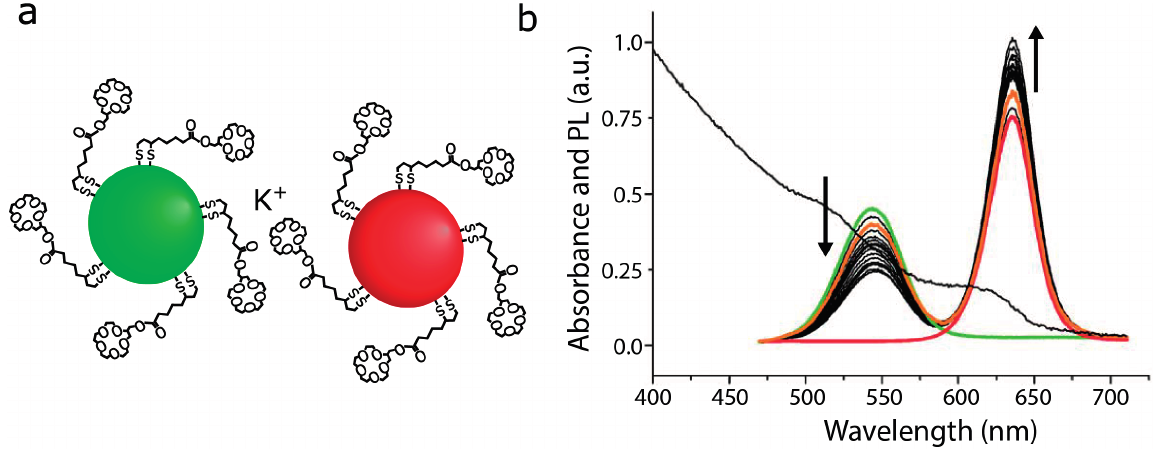
Figure 11. ( a ) Schematic of donor and acceptor QDs coated with 15-crown-5, which selectively interacts with potassium ions. Schematic is not drawn to scale; ( b ) PL spectra of the isolated donor and acceptor QDs (green and red lines, respectively). PL spectra of mixed QD populations after adding 2 n × 3.6 μ M of KClO 4 (black lines). Reversibility demonstrated by adding 1 M Na + after the n -th addition of K + (orange line). Absorption of spectrum of the QD mixture shown overlaid behind the PL spectra (black line); (b) reprinted with permission from